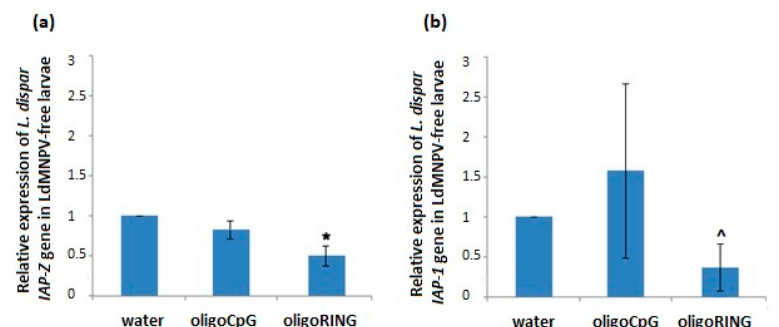
Figure 2. Expression of gypsy moth IAP-Z and IAP-1 genes after treatment with oligoDNAs. ( a ) Treatment of LdMNPV-free larvae with oligoRING (RING column) leads to significant down-regulation of host IAP-Z gene expression on the 14th day. Values represent means and standard errors of mRNA expression for 3 replicates relative to the water-treated control group. The significant difference between the oligoRING group and the water-treated control group is indicated by * when p < 0.05; ( b ) Treatment of LdMNPV-free gypsy moth larvae with oligoRING (RING column) leads to markedly decreased expression of the host IAP-1 gene on the 14th day. Values represent means and standard errors of mRNA expression for 3 replicates relative to the control water-treated control group. The significant difference between the oligoRING group and the water-treated control group is indicated by ^ when p < 0.12.